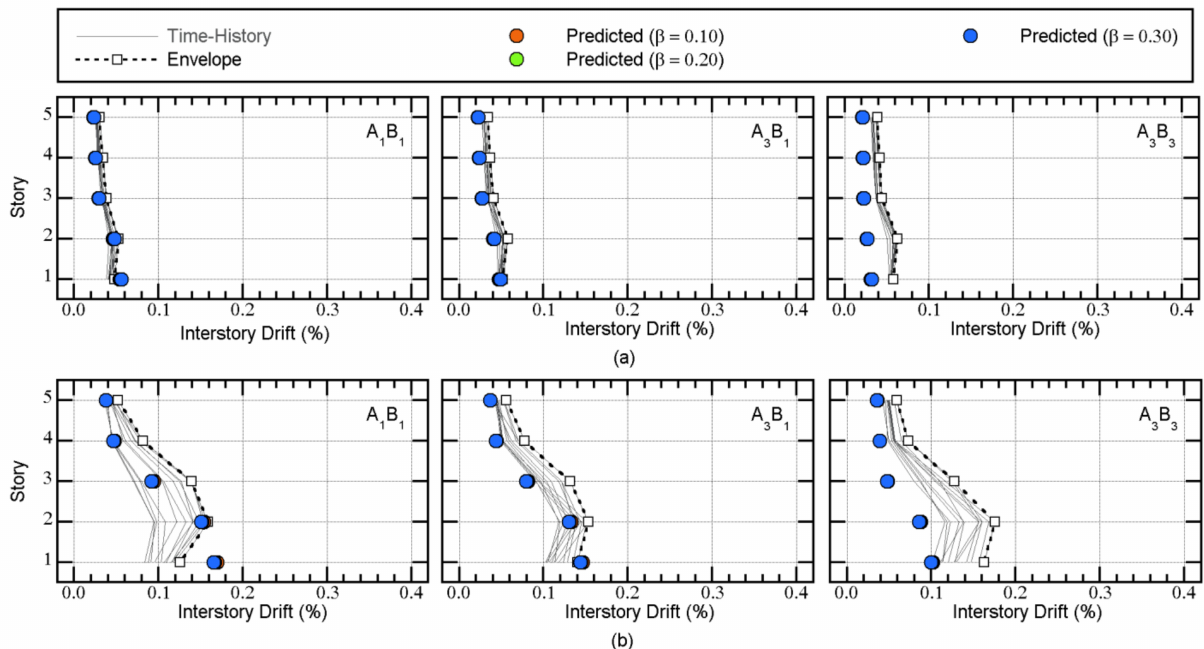
Figure 28. Comparison of the peak drift for the columns (Model-Tf44) with ( a ) UTO0414 and ( b ) UTO0416. Figures 29 and 30 show the peak displacements at two isolators (X 1A Y 6 and X 6A Y 1 ) for various angles of incidence of seismic input ( ψ ). In these figures, the displacement of each isolator was calculated as the absolute (vector) value of the two horizontal directions, and the predicted peaks are shown by the colored lines. As shown in these figures, the upper bounds of the peak displacement of the isolators can be satisfactorily evaluated using the updated MABPA presented in this study.